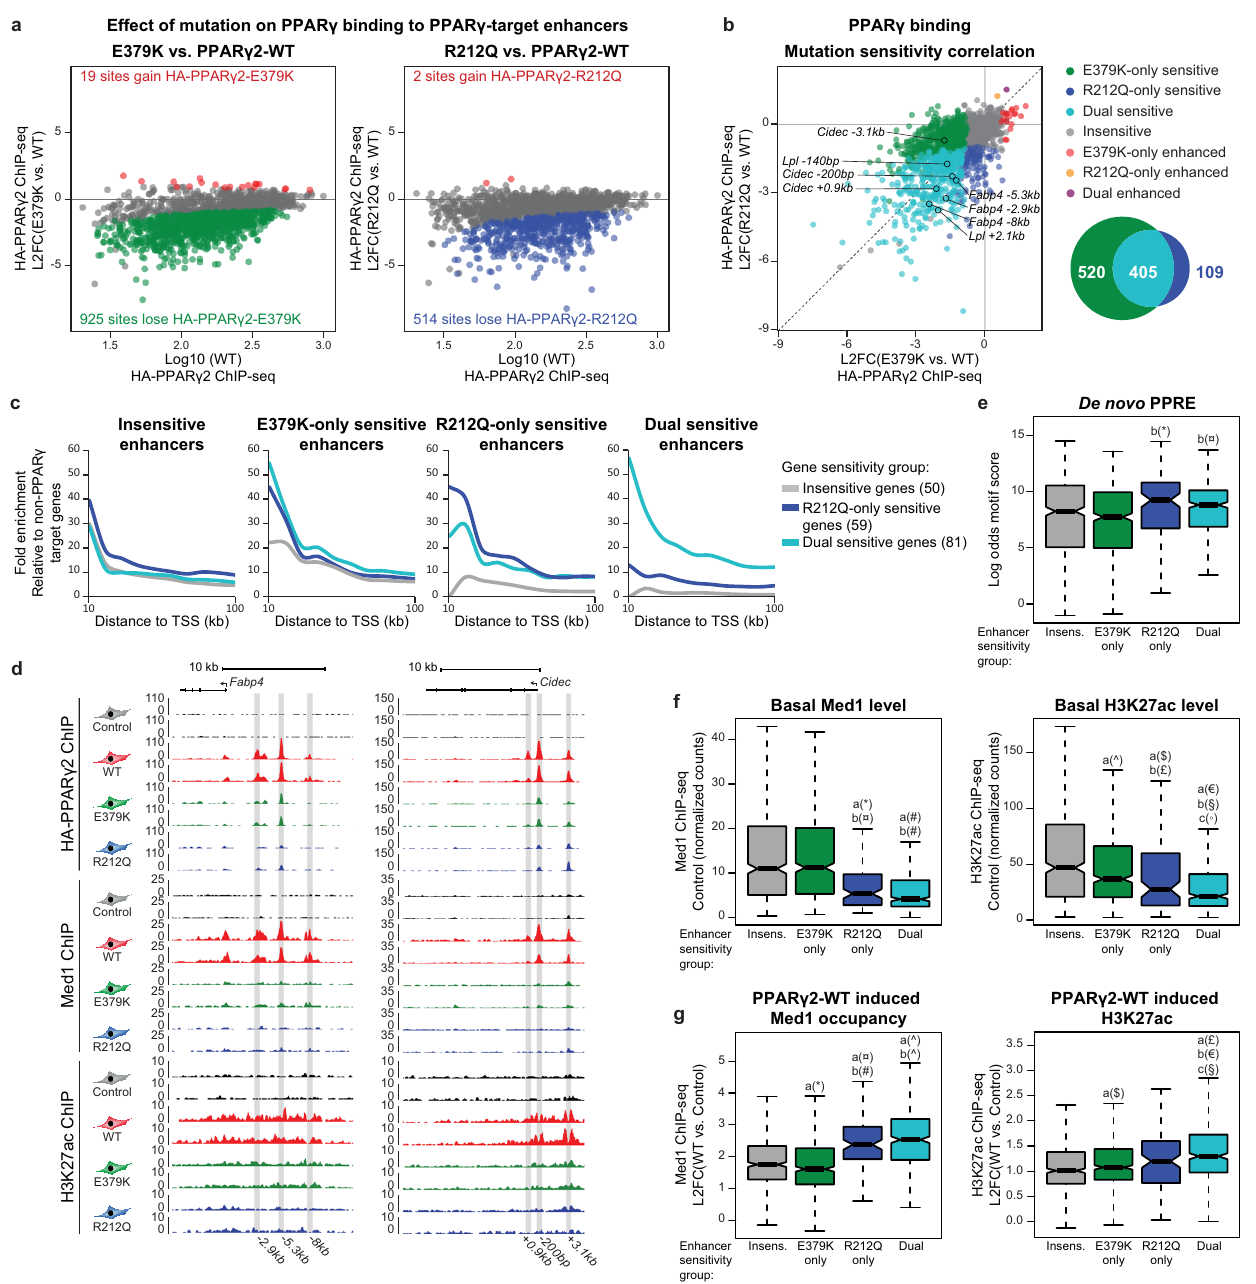
Fig. 7 | PPAR γ target enhancers display different sensitivity to mutations dependent on basal enhancer activity. a MA-plots of PPAR γ 2-E379K (left) and PPAR γ 2-R212Q (right) binding relative to PPAR γ 2-WT binding (L2FC, log2 fold change). Gained and lost binding is de fi ned by padj. (mut vs. WT)<0.05 (DESeq2 withBenjamini – Hochbergcorrection,two-sided)andthebindingintensity(mutvs. WT) increasing or decreasing by at least 25%, respectively. b Correlation of sensi- tivity to E379K mutation and R212Q mutation (left) (L2FC, log2 fold change). Selected enhancers are indicated. Venn-diagram of enhancers with mutation- facilitatedreducedPPAR γ -binding(right). c Enrichmentofenhancersinthevicinity of PPAR γ -target genes relative to the number of enhancers in the vicinity of 200 randomly selected genes not regulated by PPAR γ . R212Q-only and dual-sensitive genes are de fi ned as in Fig. 5h. Insensitive target genes are changing less than 25% comparingmutantvs.WTPPAR γ .E379K-onlysensitivegenesareexcludedfromthe analysis as the gene group is very small (17 genes). (TSS, transcriptional start site). d UCSCGenomeBrowsertrackshowingHA-PPAR γ ,Med1,andH3K27acChIP-seqat the Fabp4 -locus (left) and Cidec- locus (right). PPAR γ -target enhancers are